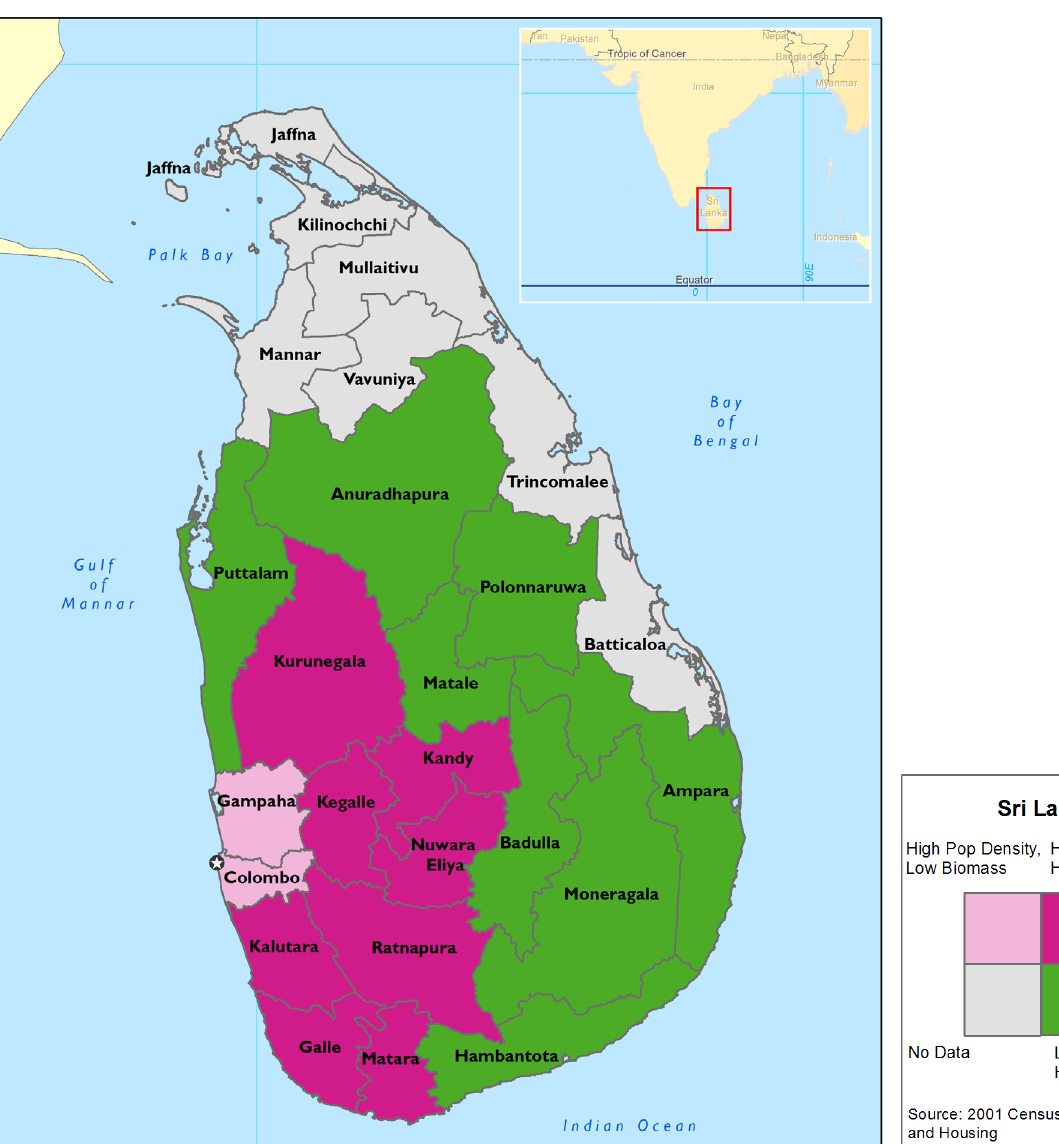
Figure 1. Sri Lanka population density and percentage of households using Biomass, by